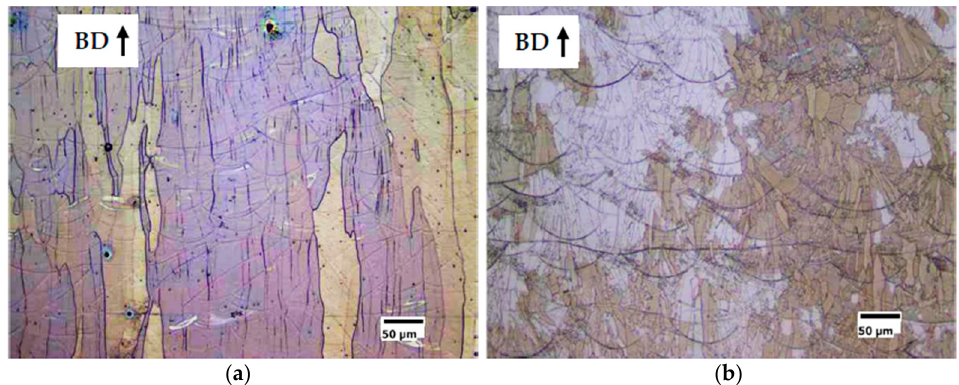
Figure 9. Columnar microstructure of longitudinal sections along the built direction (BD) of the highest density samples: ( a ) S7-FeSi3 ( E = 250 Jm − 1 , v = 1 ms − 1 , P = 250 W) and ( b ) S3-FeSi6.5 ( E = 200 Jm − 1 , v = 0.835 ms − 1 , P = 167 W).